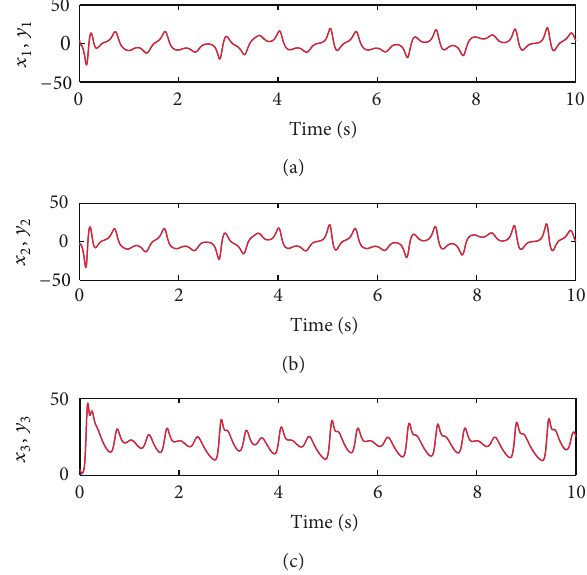
Figure 12: Synchronization of fractional-order unified chaotic system in the presence of systematic uncertainties and external disturbances with 𝛼 = 1 (blue line represents the trajectories of the drive system, while red line represents the trajectories of the response